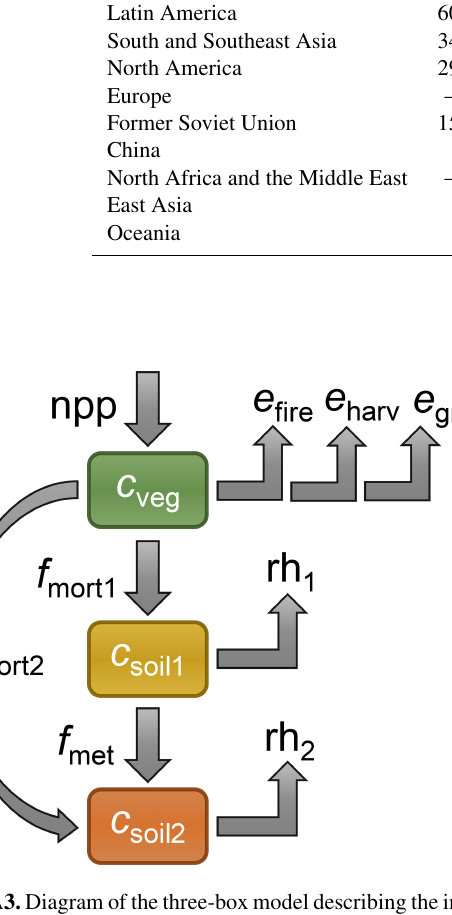
Figure A3. Diagram of the three-box model describing the intensive land carbon cycle in each (region, biome) set. The three boxes corre- spond to carbon pools in the vegetation ( c veg ), the litter ( c soil1 ), and the soil ( c soil2 ). Detailed definitions and formulations of the fluxes (gray arrows) are provided in Appendix